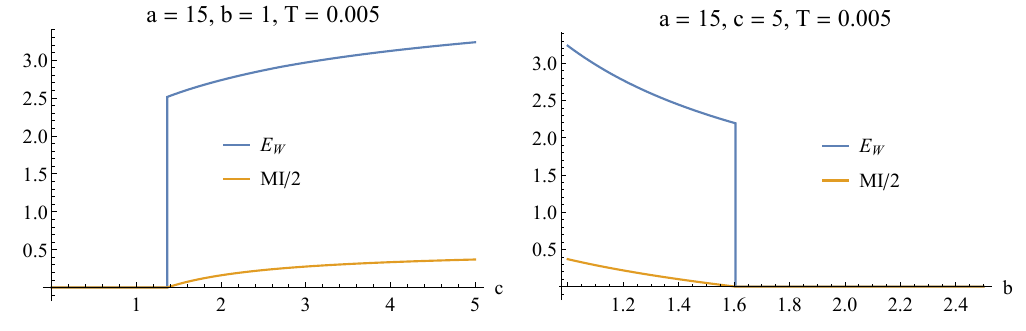
Figure 12 . EoP and MI = 2 at di(cid:11)erent con(cid:12)gurations. Left plot: E W vs c at ( a; b; T ) = (15 ; 1 ; 0 : 005). Right plot: E W vs b at ( a; c; T ) = (15 ; 5 ; 0 :